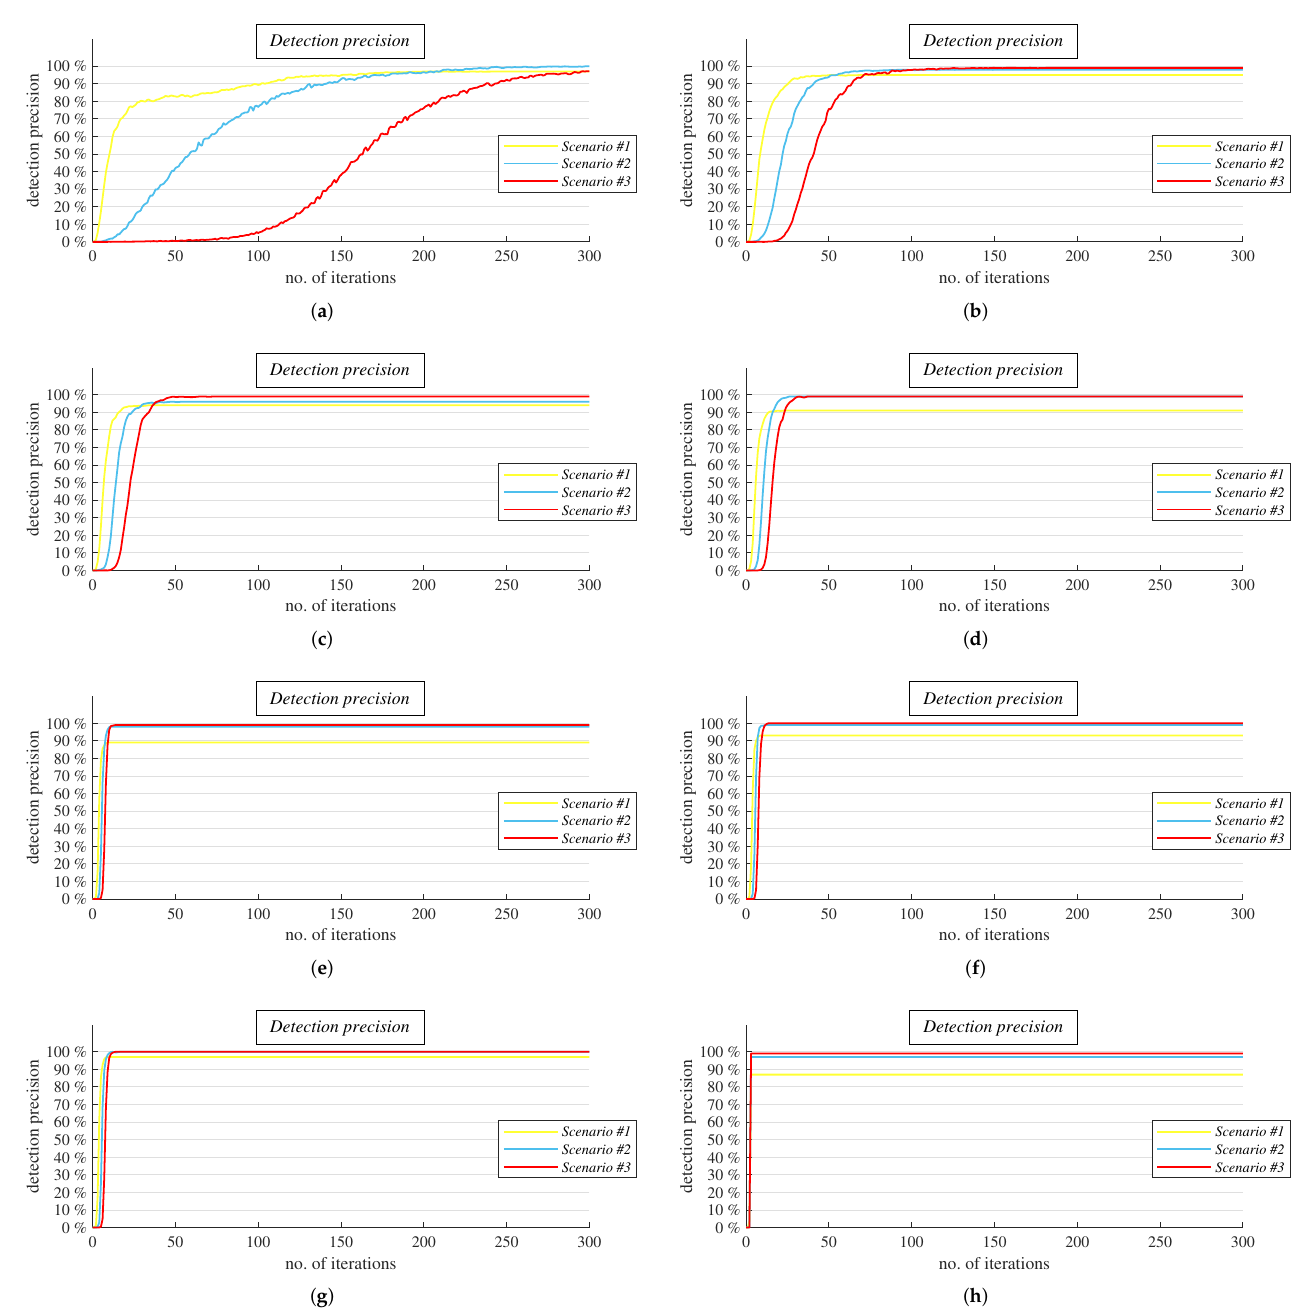
Figure 15. Evaluation of detection precision of proposed mechanism in bipartite regular graphs with various degrees under three scenarios. ( a ) Bipartite 2-regular graphs. ( b ) Bipartite 3-regular graphs. ( c ) Bipartite 4-regular graphs. ( d ) Bipartite 5-regular graphs. ( e ) Bipartite 6-regular graphs. ( f ) Bipartite 7-regular graphs. ( g ) Bipartite 10-regular graphs. ( h ) Bipartite 15-regular